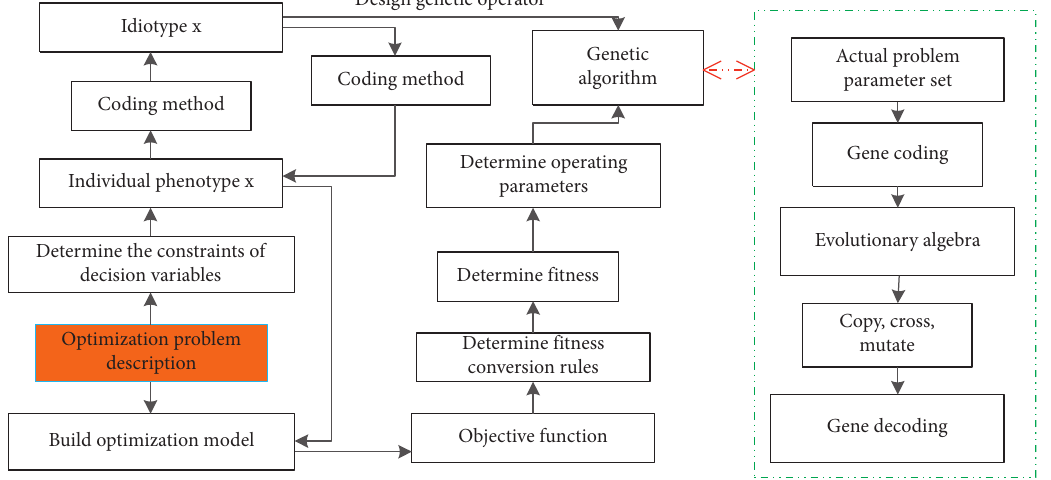
Figure 4: The construction process of genetic